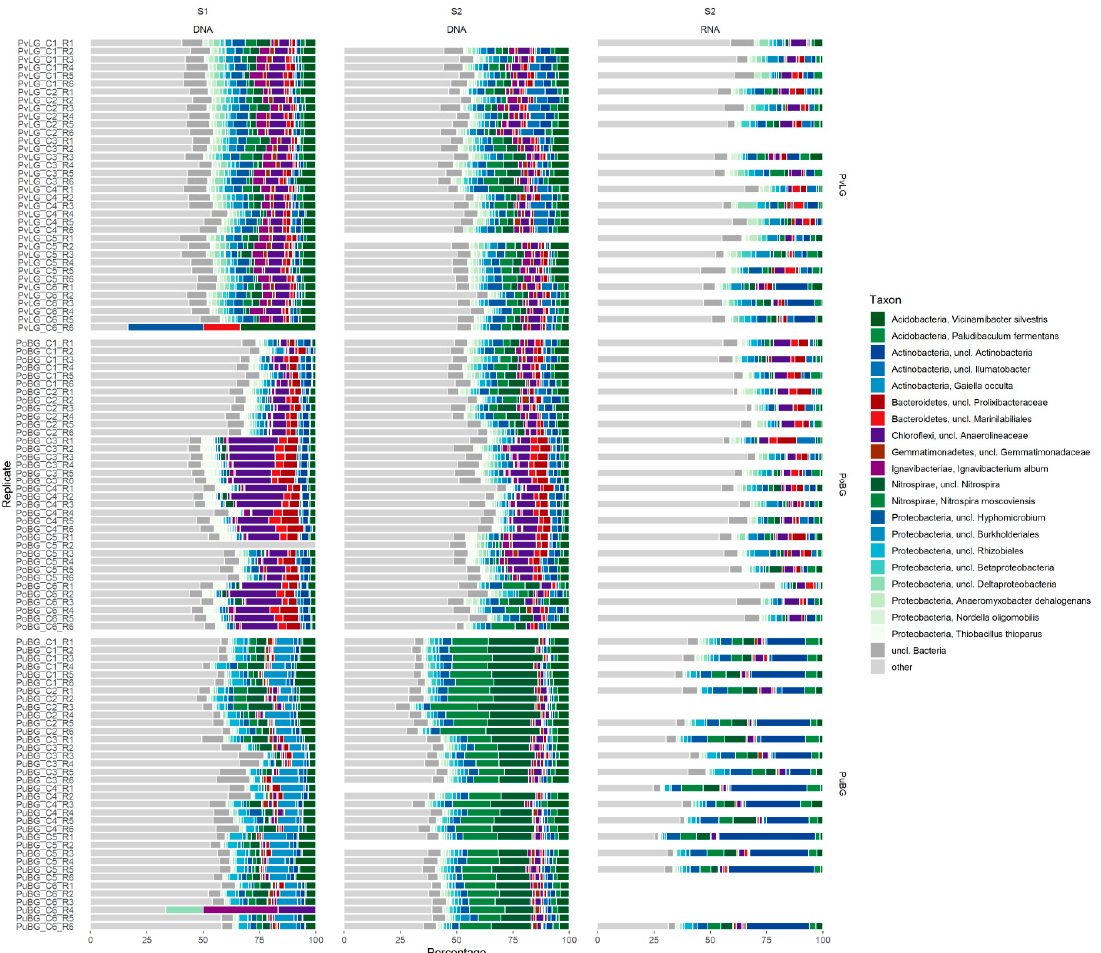
Figure 3. Bar graphs depicting taxon frequencies summarized by phylum and species level based on V3-V4 rRNA gene amplicon sequencing of extracted DNA from sediment samples associated to the three sampling sites in the Panke during two different seasons (S1 DNA and S2 DNA). Bar graphs of extracted RNA associated with the three sampling sites in the Panke during the summer season in 2017 (S2 RNA). S1: season 1 (October 2016) and S2: season 2 (June 2017).